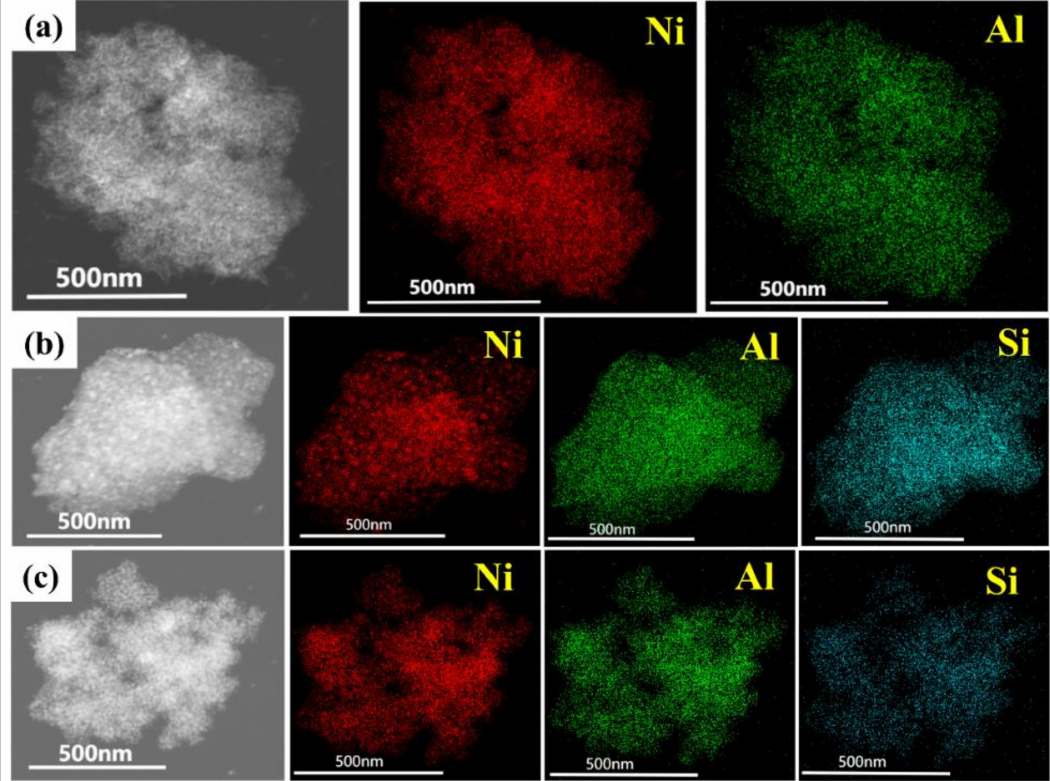
Figure 3. TEM-energy dispersive spectroscopy (TEM-EDS) images of ( a ) H-NiAl-LDO (Reprinted with permission from [34], Copyright 2022 Elsevier), ( b ) H-SiCl 4 -NiAl-LDO, ( c ) H-SiO 2 -NiAl-LDO.